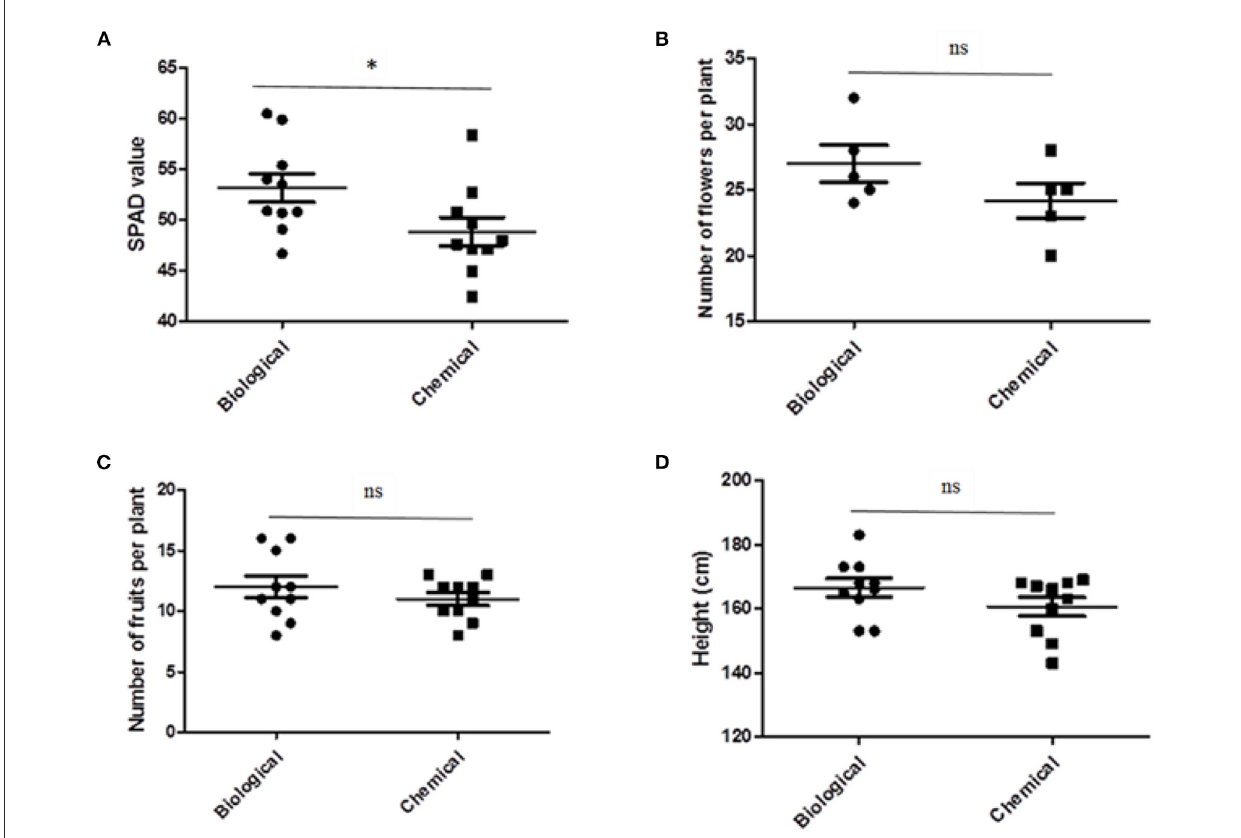
FIGURE1 The effect of biological and chemical treatments on leaf SPAD value (A) , number of flowers (B) and fruits (C) per plant and height (D) of sweet pepper plants. Asterisk indicates a statistically significant effect (* p < 0.05), whereas “ns” indicates not significant ( p > 0.05) between biological and chemical